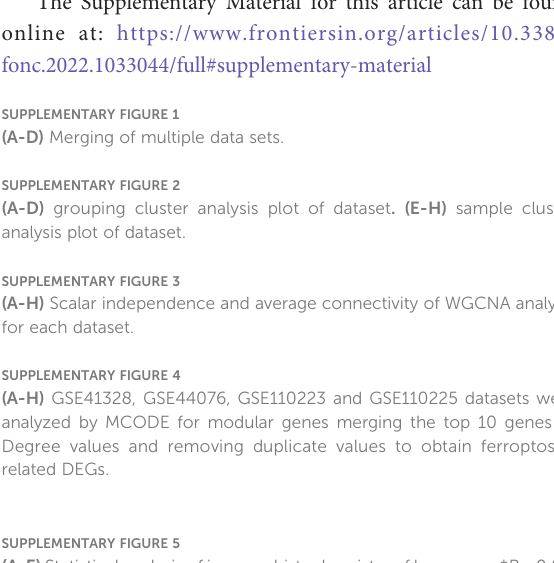
SUPPLEMENTARY FIGURE 6 The correlation of fi ve core genes in the TIMER database in colon